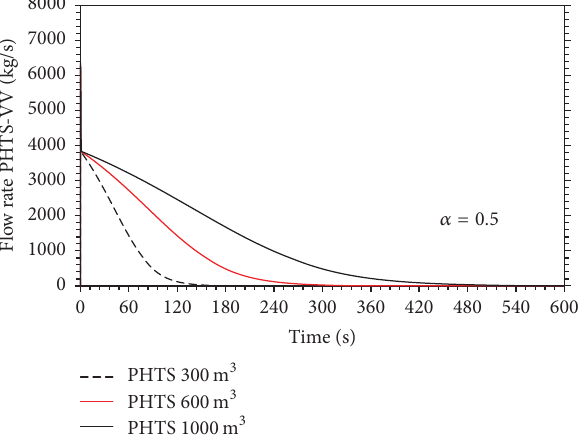
Figure 7: Flow rate from the break (0.11m 2 ).